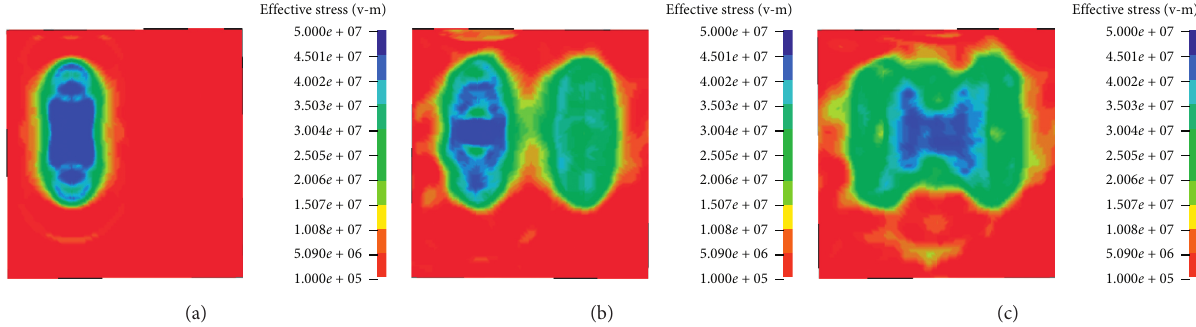
Figure 9: 15m × 5.5m effective stress of the section between the front holes at different times. (a) t � 1.99 ms. (b) t � 43.49ms. (c) t � 144.00ms.